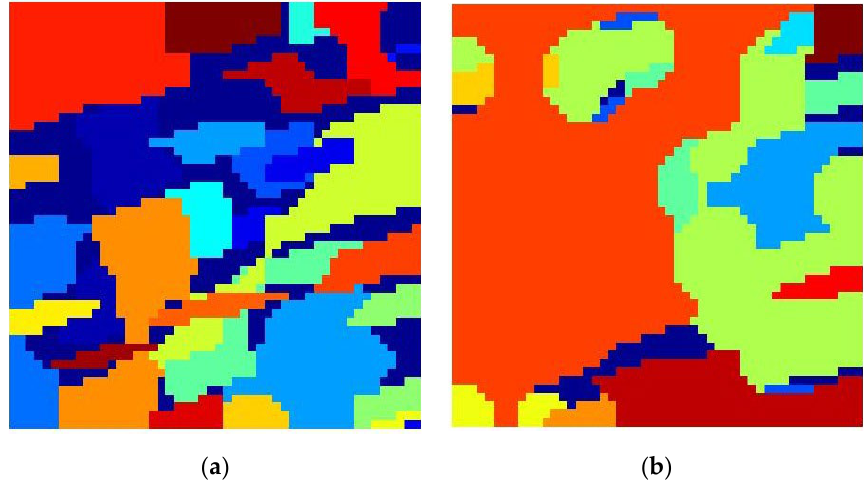
Figure 7. Cluster index labelling for: ( a ) Indian Pines and ( b ) Pavia University.